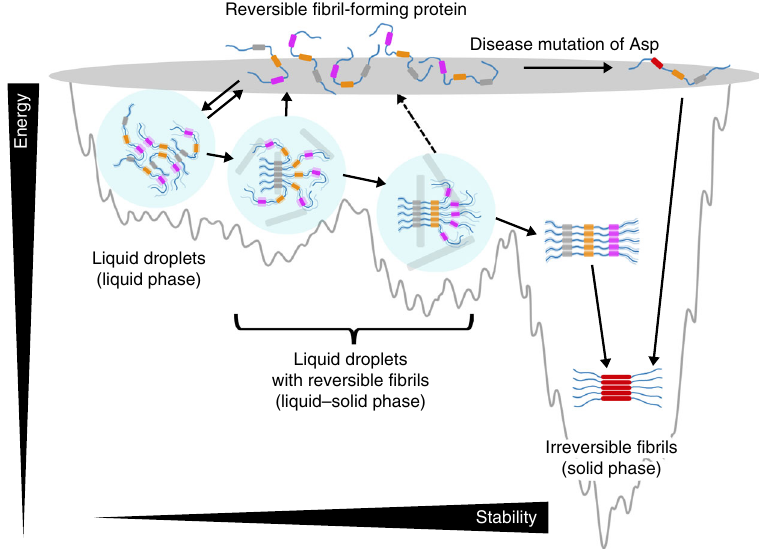
Fig. 6 Schematic illustration of hnRNPA1 phase transition. Reversible amyloid-forming proteins such as hnRNPA1 contain multiple RACs that may be gradually involved in the fi bril spine as maturation. The less RACs involved in the fi bril spine, the more reversible the fi brils would be. Disease mutation of Asp promotes the formation of irreversible fi brils. RACs are shown as gray, orange, and magenta bars. Reversible fi brils are shown as light gray sticks. Light blue solid circles indicate droplets. Irreversible amyloid-forming cores are shown as red